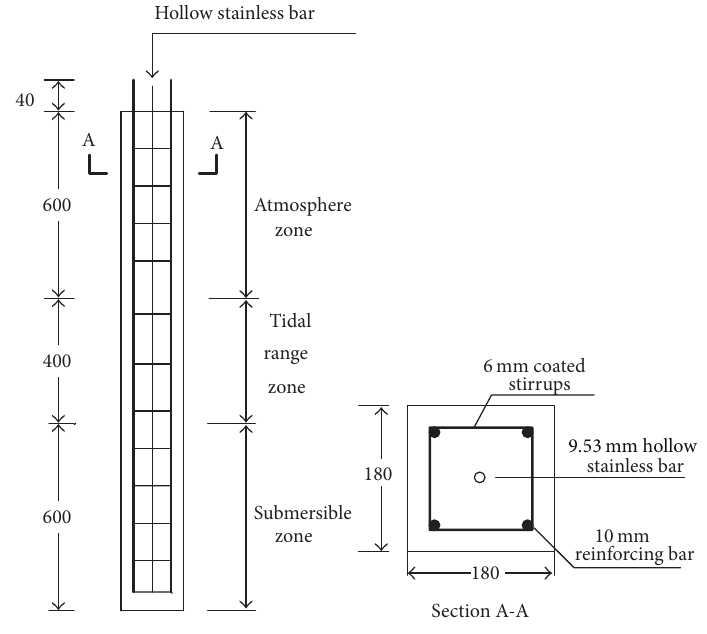
Figure 1: Specimen geometry